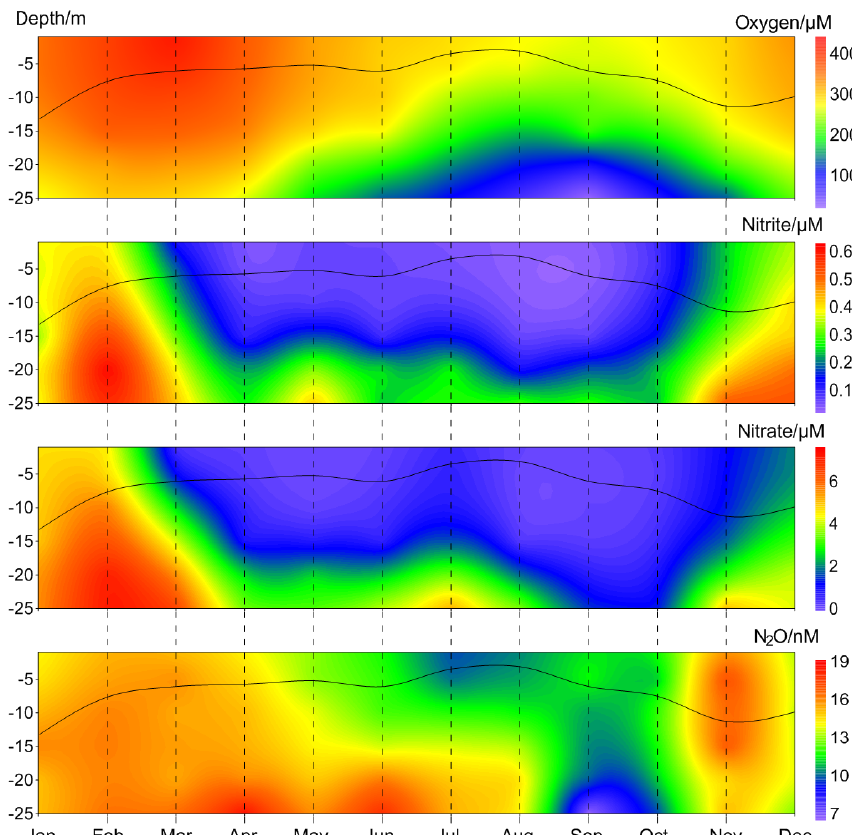
Figure 4. Average vertical distributions of dissolved O 2 , NO − black line indicates the mixed layer depth, which was calculated based on a potential density anomaly of 0.15kgm − 3 from the sea surface